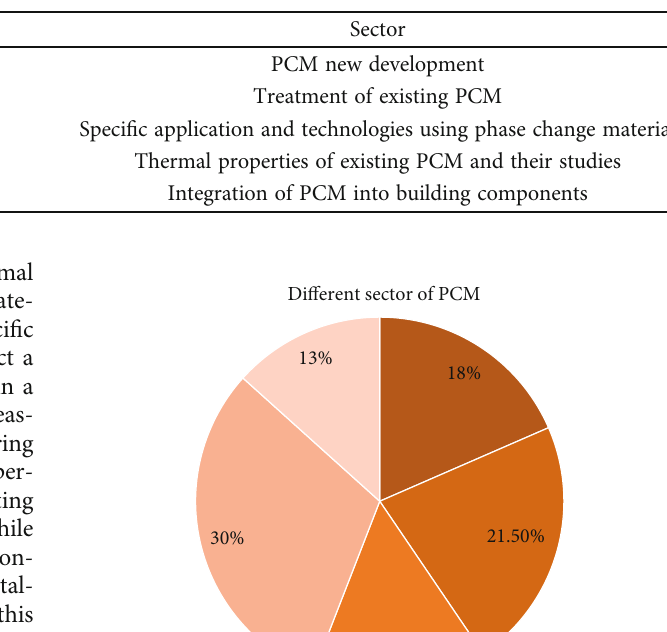
Figure 5: Variation of phase change material per Table 2: Comparison of PCM dealing in di ff erent sectors.